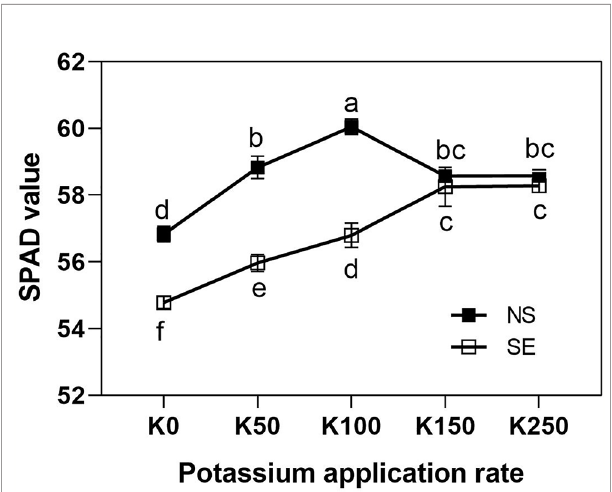
FIGURE 2 | The SPAD values of fl ag leaves of winter wheat under different treatments. Values are means of SPAD values of 10 and 25 days after anthesis. The error bars stand for standard deviations of the means of fi ve independent biological replicates. Different letters represent signi fi cant difference from each other according to two-way ANOVA followed by least signi fi cant difference (LSD) multiple comparison ( P < 0.05). NS: no shading treatment; SE: shading from the 1st day to the 10th day after anthesis (shading at early fi lling stage for 10 days, SE); Five potassium rate: 0 (K0), 50 (K50), 100 (K100), 150 (K150), and 250 (K250) mg K 2 O kg -1 soil in the form of KCl.